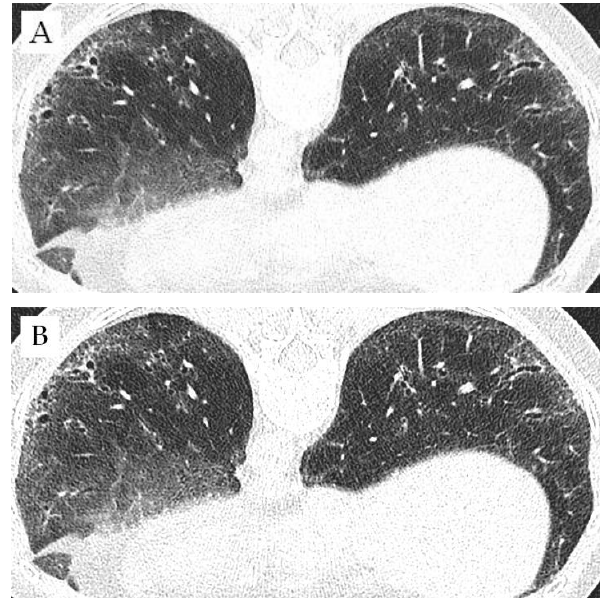
Figure 4. Basal lung segments of a 46-year-old patient with a modified Rodnan Skin Score (MRSS) of 7 points as a 512-pixel matrix image ( A ) and a 1024-pixel image ( B ). Table 5. Interreader agreement for the assessment of the different subcategories and the total score for both, the kernel, and the matrix comparison. Kernel Matrix Criterium ICC Criterium ICC Sharpness 0.05 Sharpness 0.36 Noise